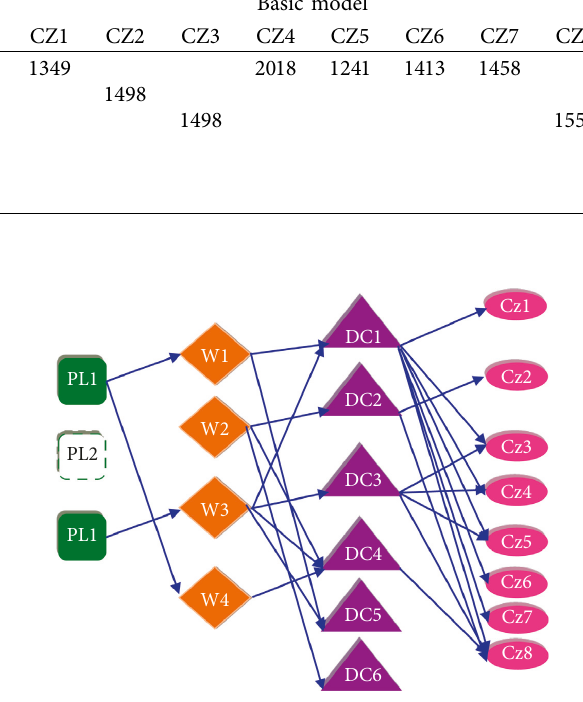
Figure 5: Network structure in year 2 and for the developed model with new financial